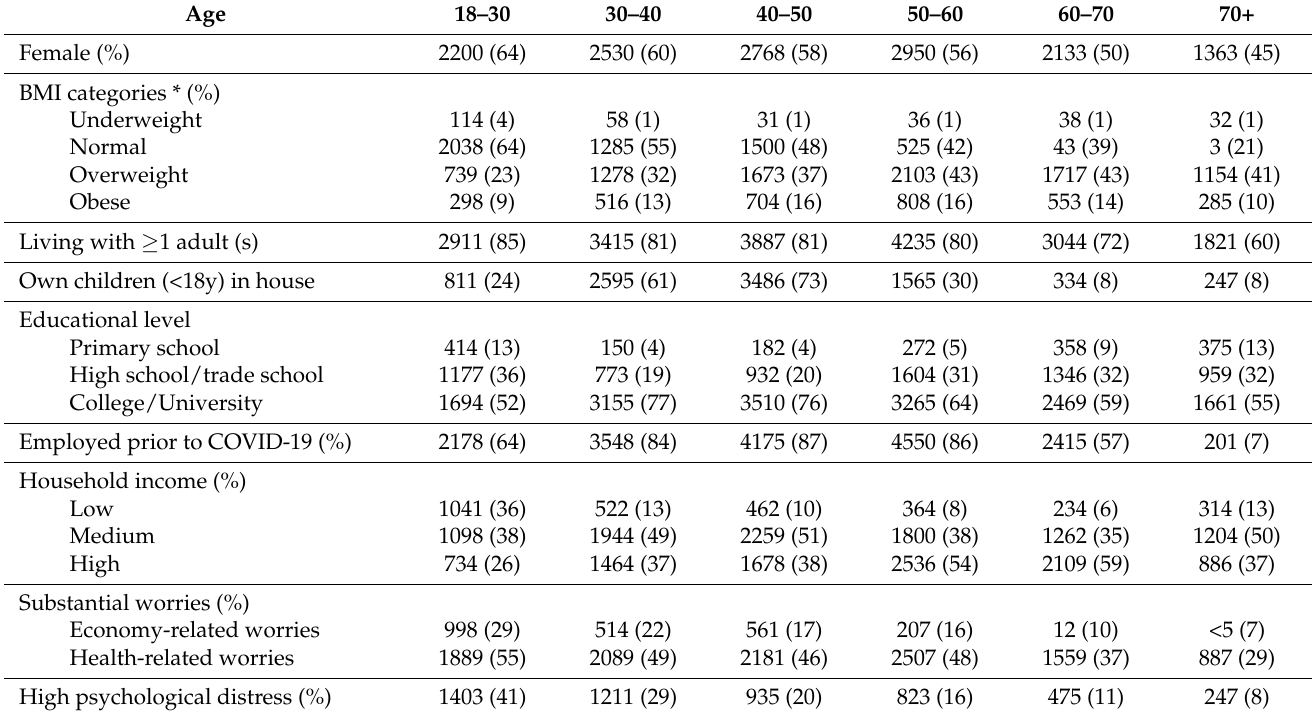
Table 1. Baseline characteristics of the